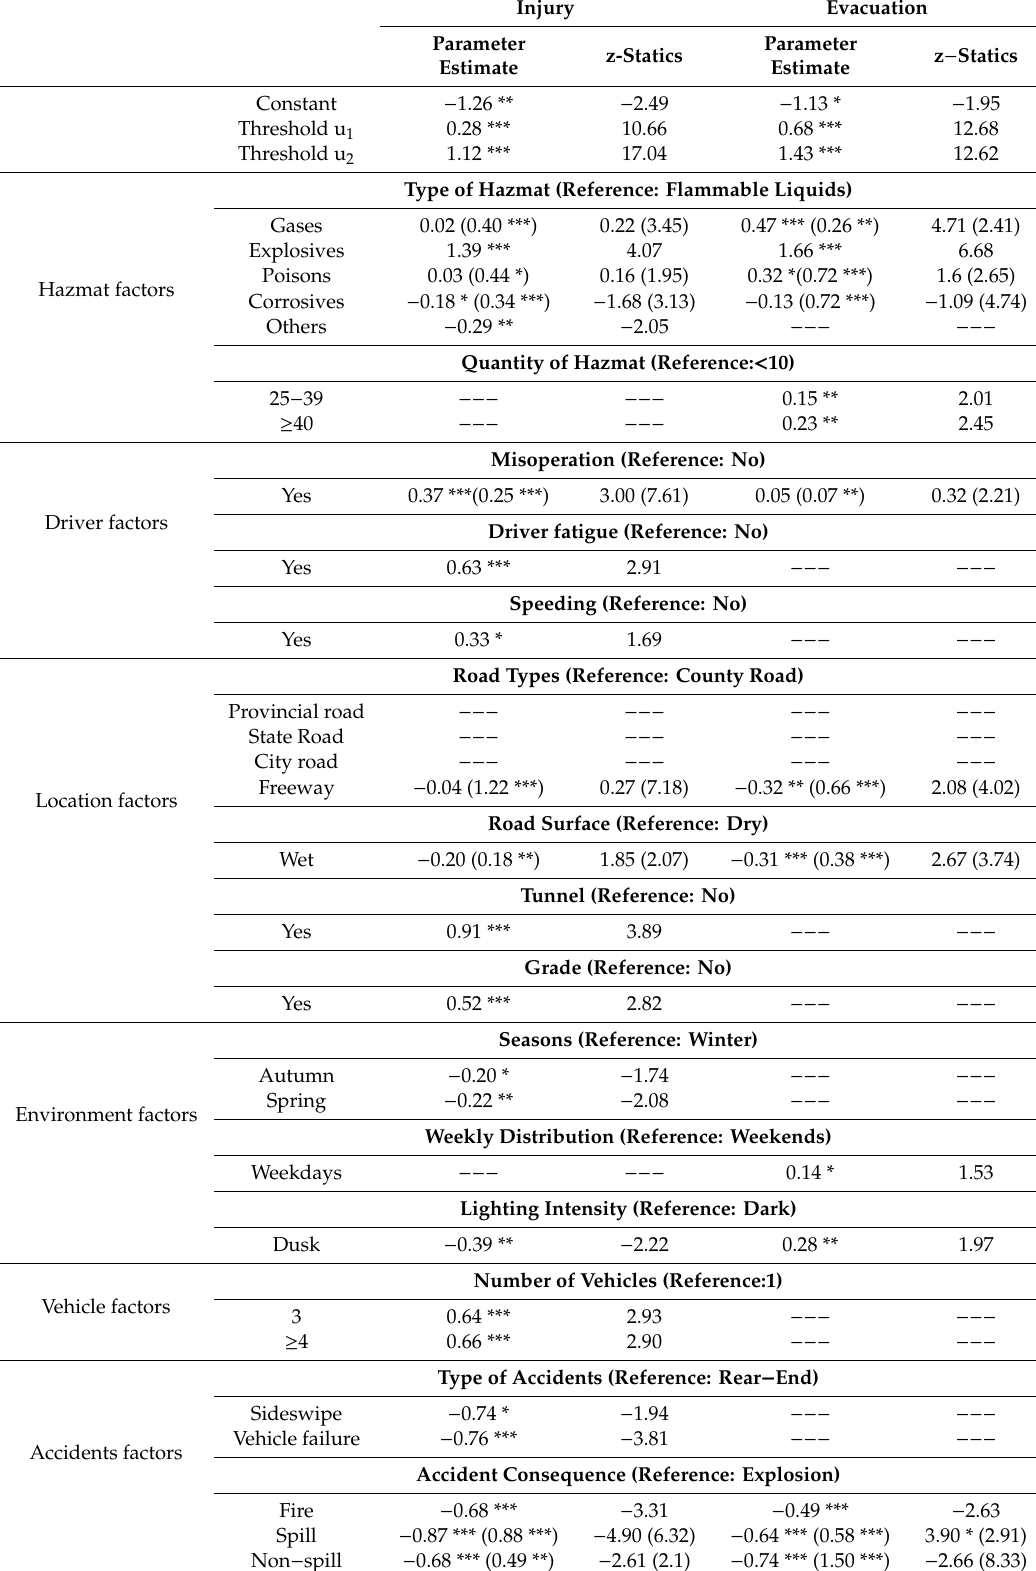
Table 3. Estimated results of the RPOP